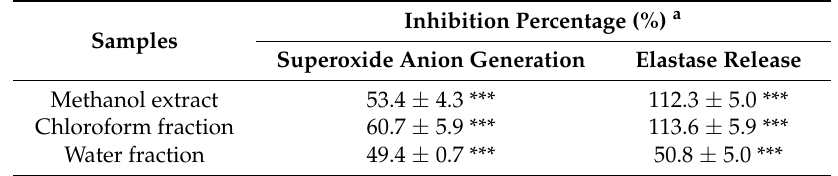
Table 1. Inhibition of P. pterocarpum leave extract and fractions on superoxide anion generation and elastase release in human